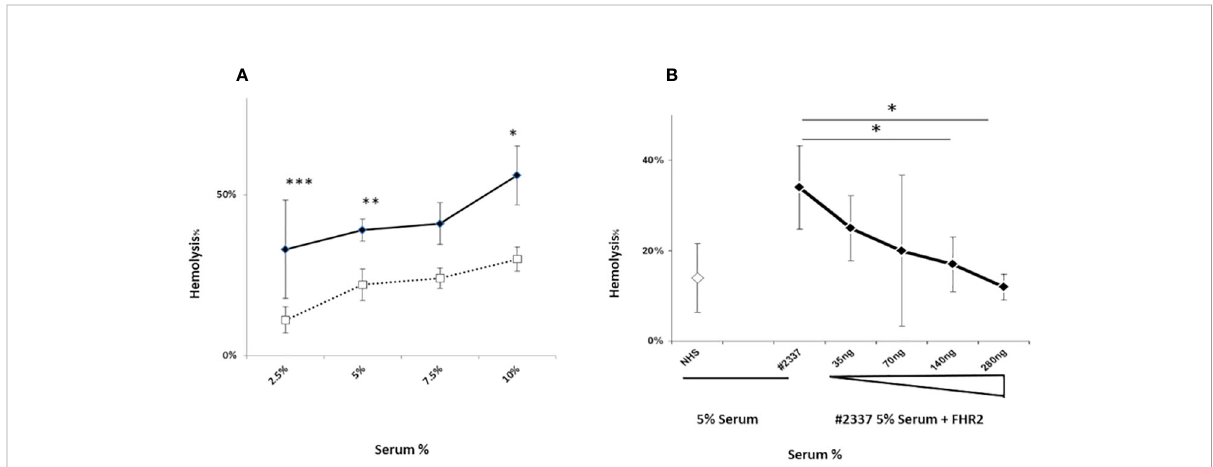
FIGURE 2 A FHR2 defect results in activation the complement alternative pathway. (A) Lysis of guinea pig erythrocytes. Guinea pig erythrocytes were incubated with increasing concentrations (2.5%, 5%, 7.5%, or 10%) of patient serum HR#2337 ( fi lled rhombus) or NHS (open square). Lysis was determined by measuring the absorbance of released hemoglobin at 414 nm. The patient ’ s serum induced more erythrocyte lysis (33%, 39%, 41%, and 56%) than NHS (11%, 22%, 24%, and 30%). The difference was statistically signi fi cant at serum concentrations of 2.5%, 5%, and 10%. The results are mean ± standard deviation (SD) of three independent experiments. * p < 0.05, ** p < 0.01, *** p < 0.001. (B) Guinea pig erythrocytes were incubated with 5% NHS (open rhombus) or 5% HR#2337 serum ( fi lled rhombus) alone or enriched with increasing amounts (35 ng, 70 ng, 140 ng, or 280 ng) of recombinant FHR2. The addition of recombinant FHR2 reduced erythrocyte lysis from 34% to 12%. The results are mean ± SD of three independent experiments. * p <